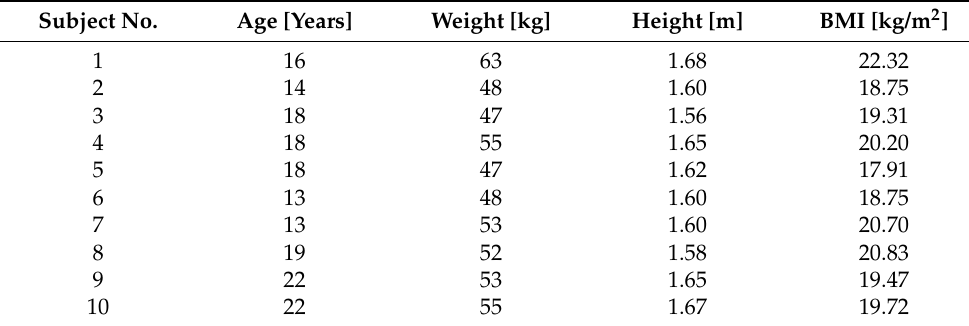
Table 1. Main characteristics of the tested